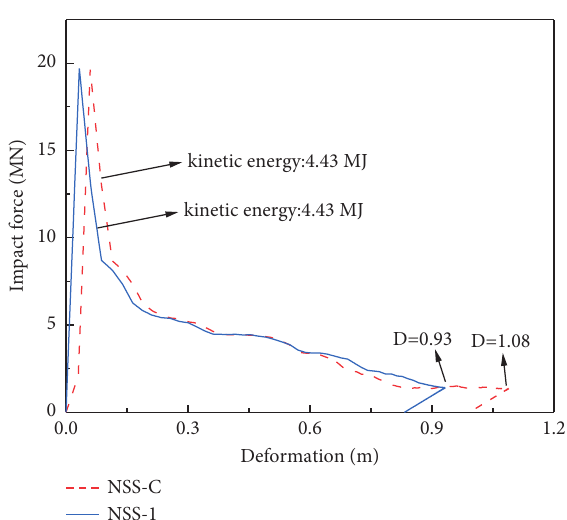
Figure 13: a − P ( a ) comparison calculated by NSS and